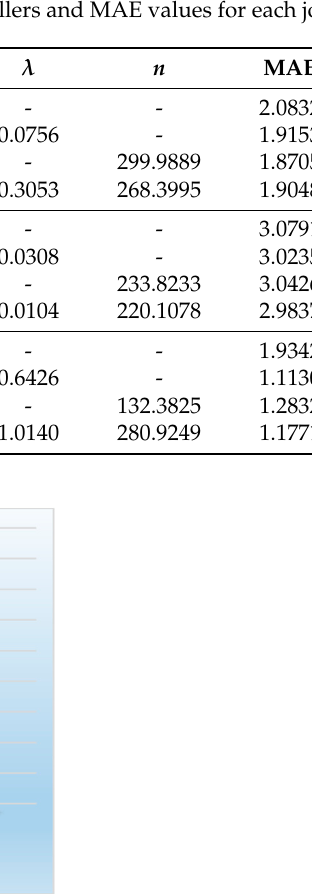
Figure 11. Trajectory tracking performance of PID, FOPID, PTID and FOPTID controllers for each joint. As shown in Figure 11, all of the actual joint positions can track the desired joint trajectories by using the tuned controllers. It is inferred that a remarkable tracking performance for all joints is achieved by the PTID and FOPTID controllers. Furthermore,